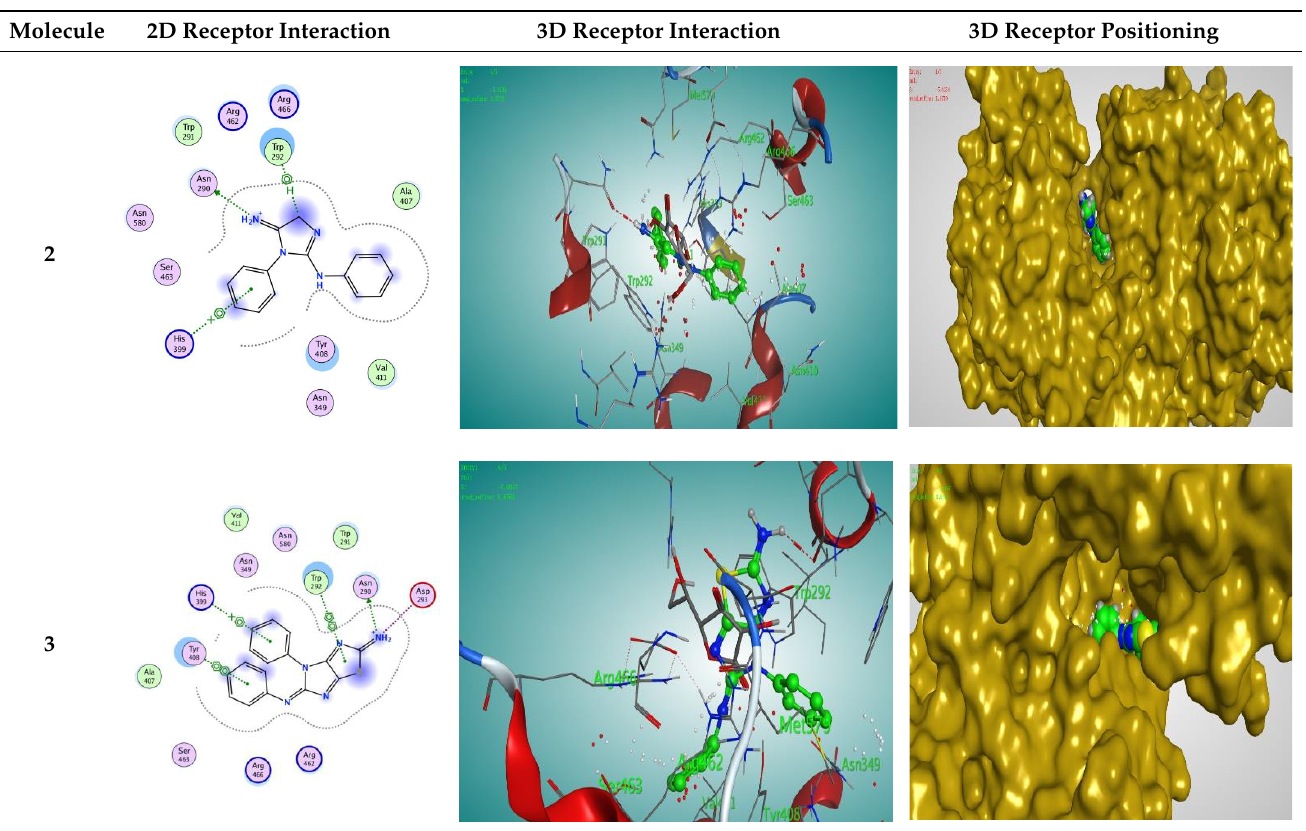
binding pocket of Streptococcus pneumoniae hyaluronate lyase.